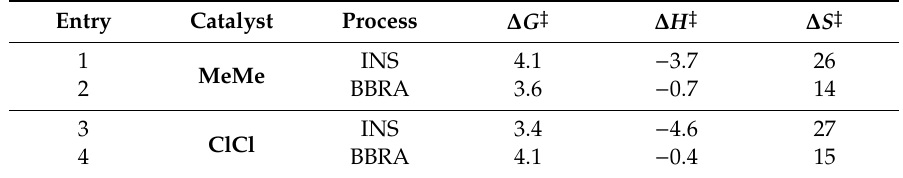
Table 4. Gibbs free energy, enthalpy, and entropy di ff erences estimated by DFT for BBRA and insertion (INS) TS with respect to the β -agostic Zr-alkyl cation (in kcal / mol; see also Figure 4). Entry Catalyst